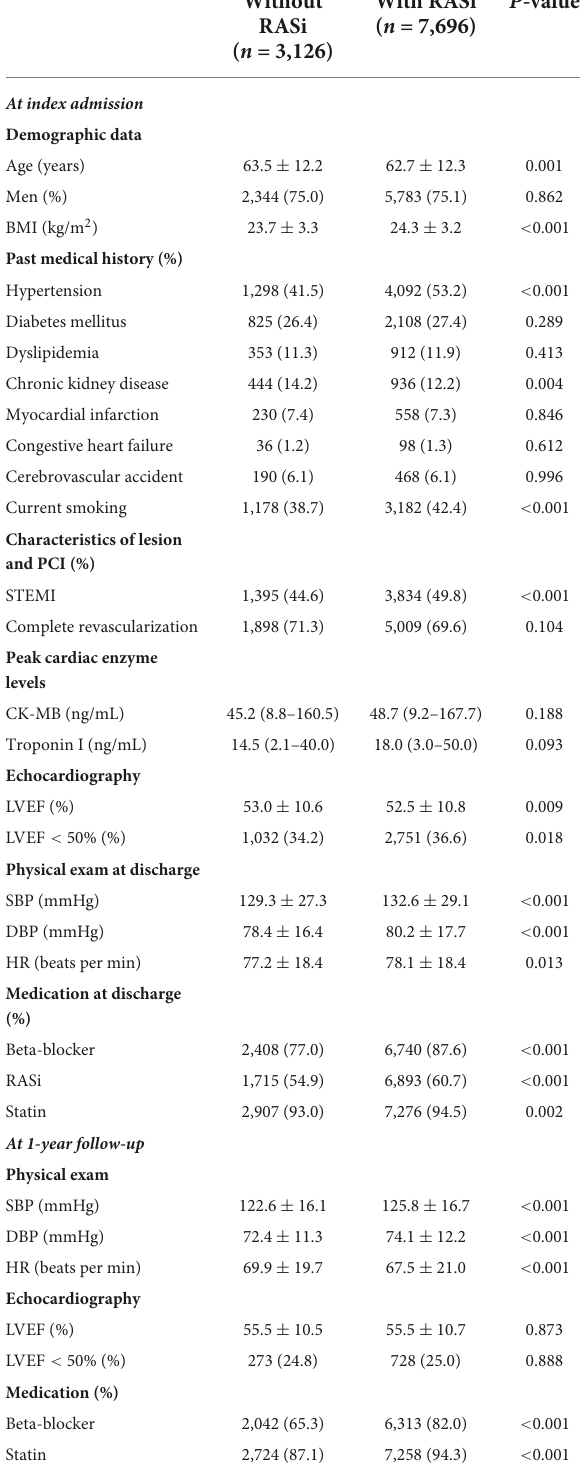
TABLE 1 Clinical characteristics based on use of RAS-inhibitor at 1-year follow-up. Without